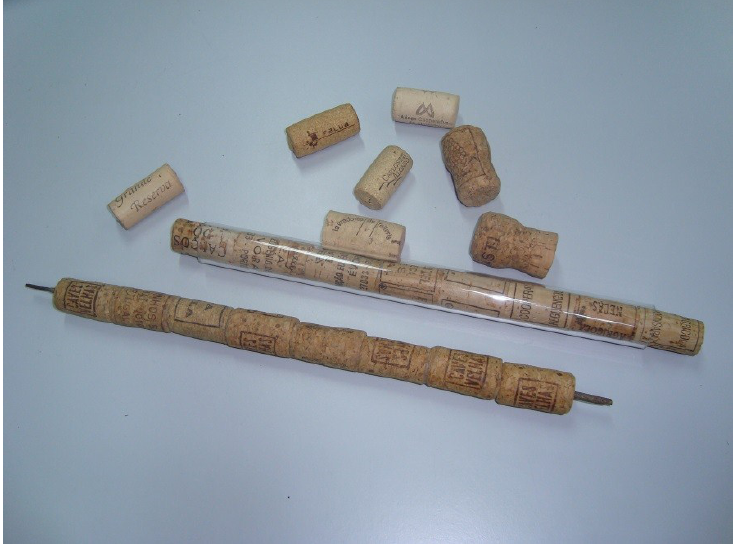
Figure 4. Batons of used cork